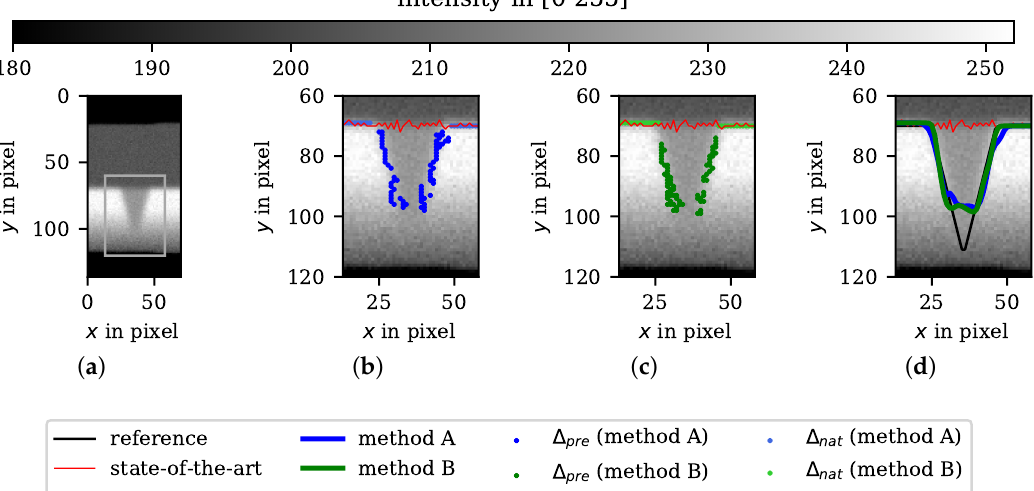
Figure 7. Simulated thermographic flow visualization image with premature flow transitions along the flanks of a turbulence wedge. ( a ) Rotor blade surface section with a laminar (brighter) and turbulent (darker) flow regime. The rectangle marks the selected area shown in panels ( b – d ). ( b , c ) Evaluation of local gradient maxima for both introduced image processing methods A (blue) and B (green) and the state-of-the-art method (red). ( d ) True flow transition line in black as a reference as well as all